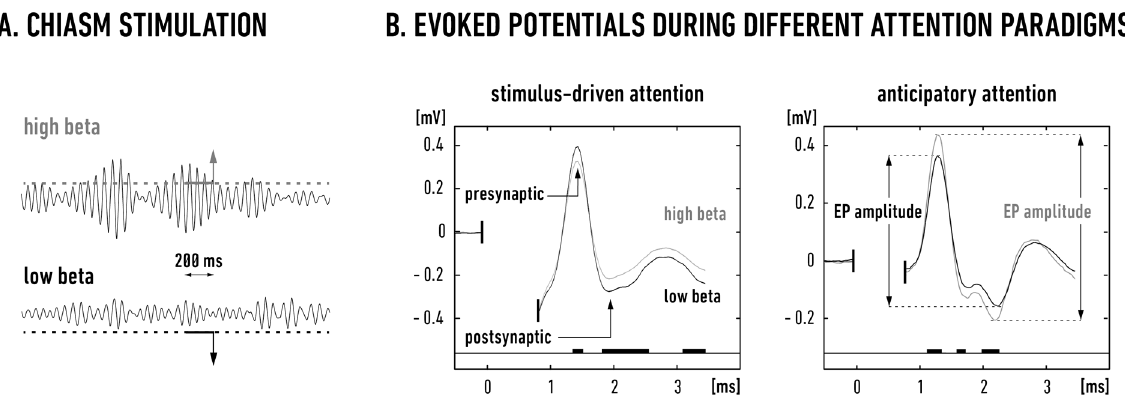
Fig 3. Summary of evoked potentials analysis. A. The EPs recorded during visual trials were clustered off-line to either high beta or low beta groups based on the strength of the digitally band-pass filtered beta signals (16 – 24 Hz) preceding chiasmatic stimulation (see the Methods section). The drawing presents two exemplary sweeps of these filtered signals with the corresponding high and low beta amplitudes. The threshold values (dotted horizontal lines) were set based on the average amplitude of the beta signal from all visual trials on a given experimental day. The vertical arrows (matched in time for illustration purposes) indicate the timing of two chiasmatic stimulations that were preceded by 200 ms of the eruption (upper sweep, gray horizontal line) or depression (lower sweep, black line) of beta oscillations. B. Examples of the averaged EPs (recorded for the two behavioral paradigms in two different animals) calculated from the clustered data after beta depression (black lines; means were obtained from 43 clustered EPs in the stimulus-induced and from 32 in the anticipatory task) or beta eruption (gray lines; means were obtained from 47 clustered EPs in the stimulus-induced and 35 in the anticipatory task). Electrical stimulation of the optic chiasm was delivered at time zero (artifact removed from the picture). The thick black horizontal lines denote significant differences between the corresponding values of the two mean EPs at the same latency (Student's t-tests with FDR correction for multiple comparisons; P (cid:1) 0.05). Note that during the high beta state, the amplitudes of the cortical EPs decreased in the stimulus-driven attention paradigm (cat B, VCx 17/2), and increased in the anticipatory attention paradigm (cat C, VCx 17/3).